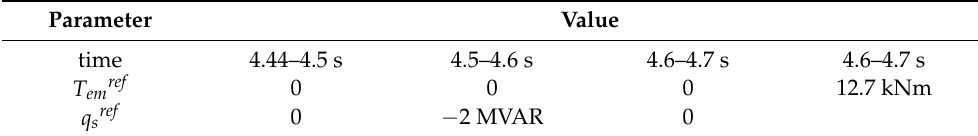
Table 2. Reference signal values set in simulation.